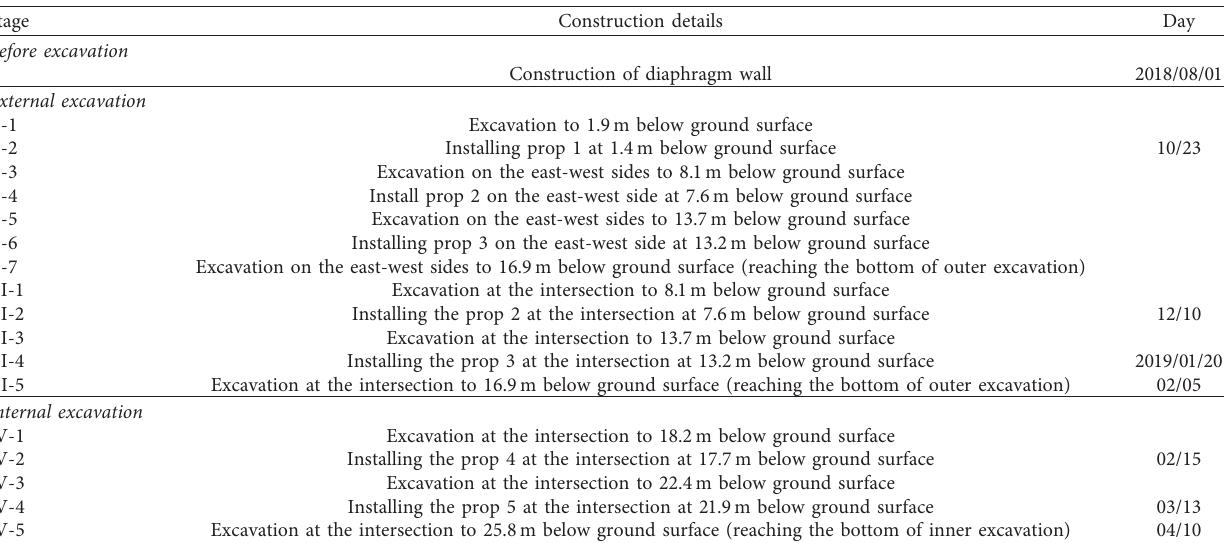
Table 3: Construction sequence for the finite element